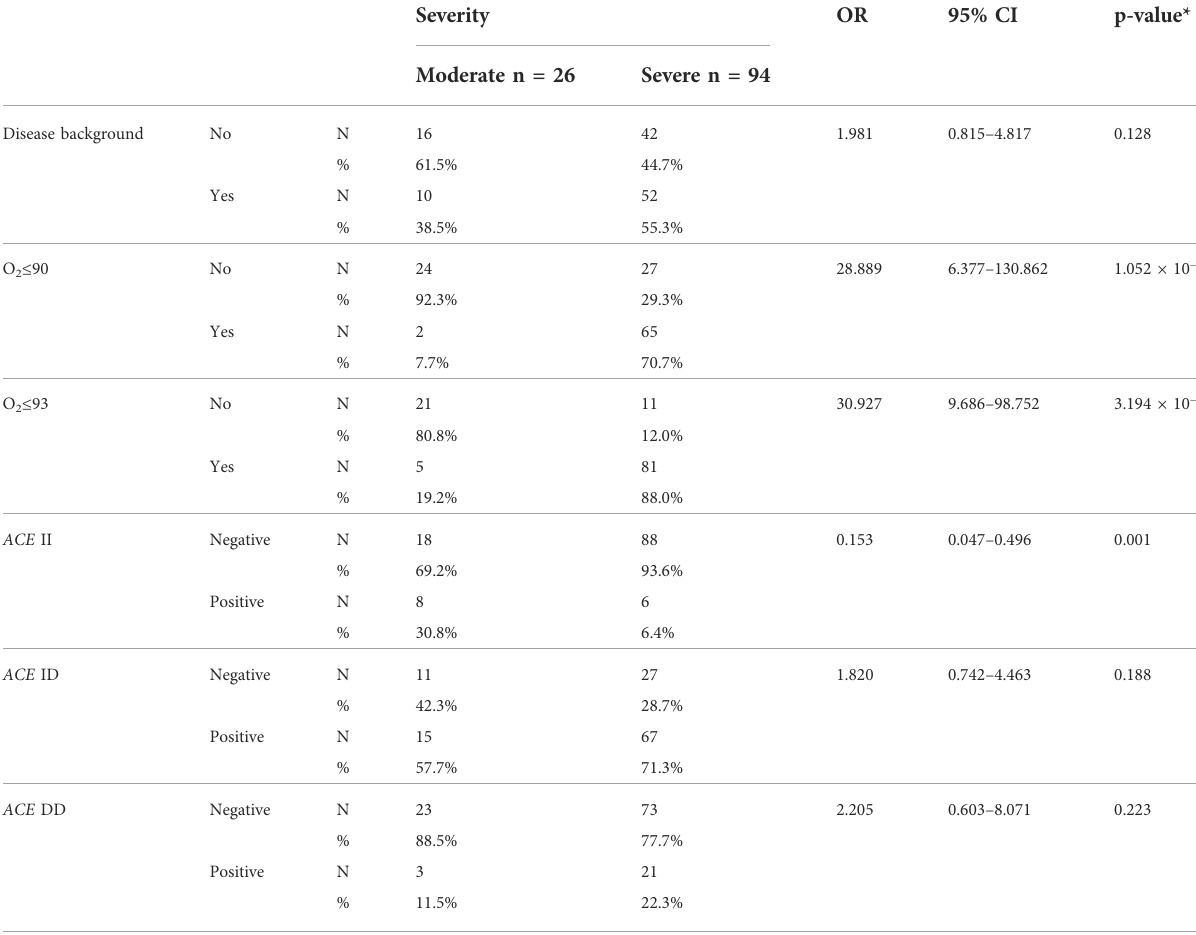
TABLE3Analysisoftheeffectsofbackgrounddisease(thesumofthediseasementionedinTable1),O 2 saturation,and ACE polymorphismondisease